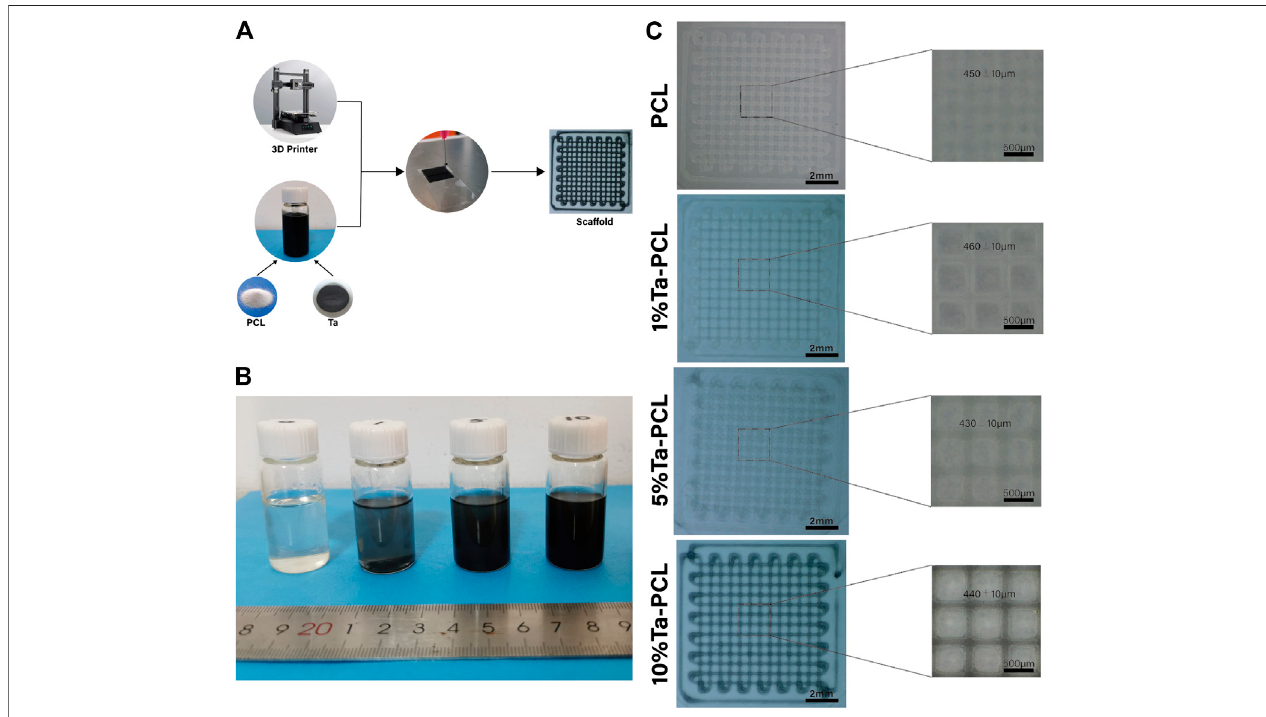
FIGURE 1 | The characterization ofTa/PCL scaffold. (A) The synthesis process of Ta/PCL. (B) The general view of Ta/PCL solution. (C) Front view ofthe structure of Ta/PCL.